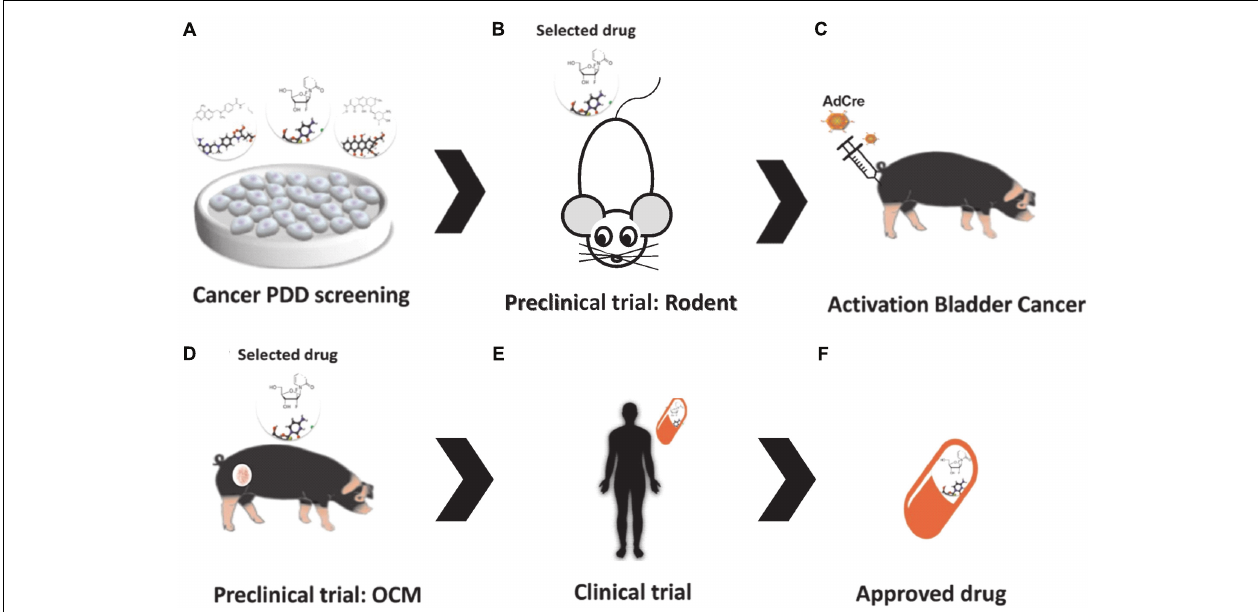
FIGURE 1 | Drug discovery in the Oncopig Bladder Cancer Model. (A) Bladder Cancer PDD. (B) Pre-clinical trials: in vivo drug testing in rodent model. (C) Oncopig Bladder Cancer Model: intravesical AdCre injection activates expression of the mutated oncogenes ( TP53 R 167 H and KRAS G 12 D ), resulting in tumor formation. (D) Pre-clinical trial II: in vivo drug testing in the Oncopig Bladder Cancer Model. (E) Clinical trials. (F) Drug selection.